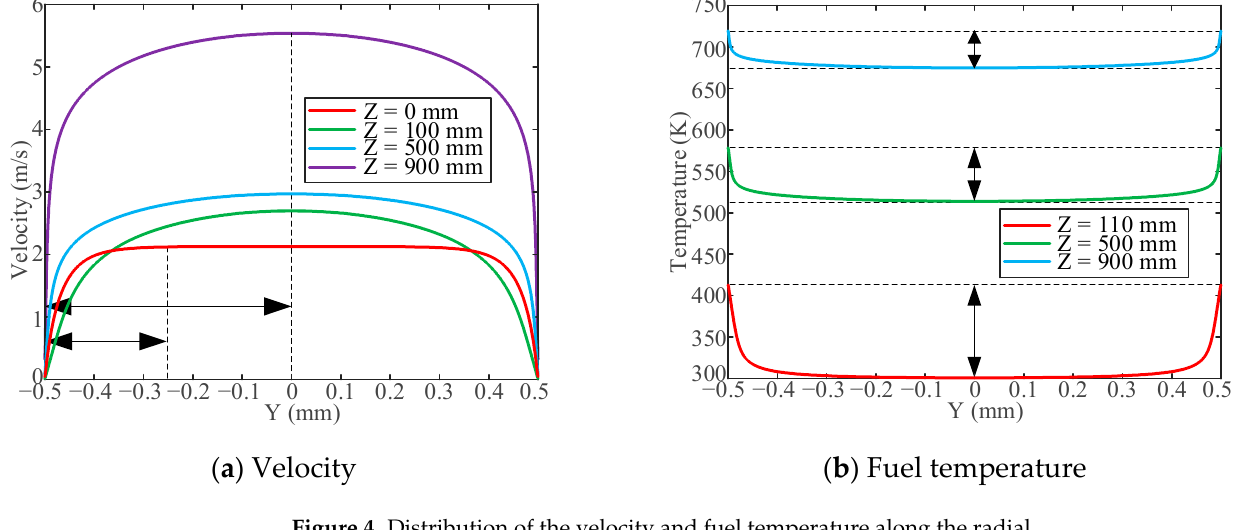
Figure 4. Distribution of the velocity and fuel temperature along the radial.